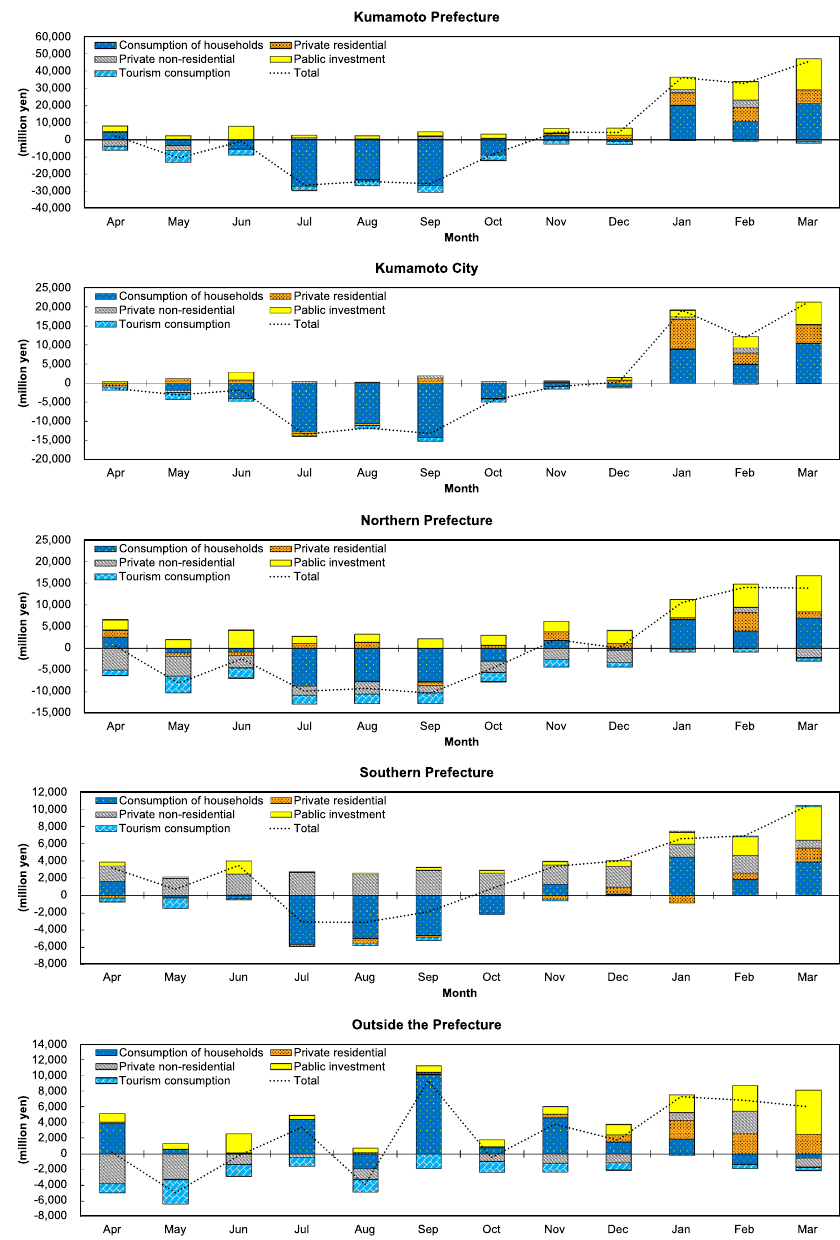
(cid:31) V k · l m by (cid:31) k (cid:31) l